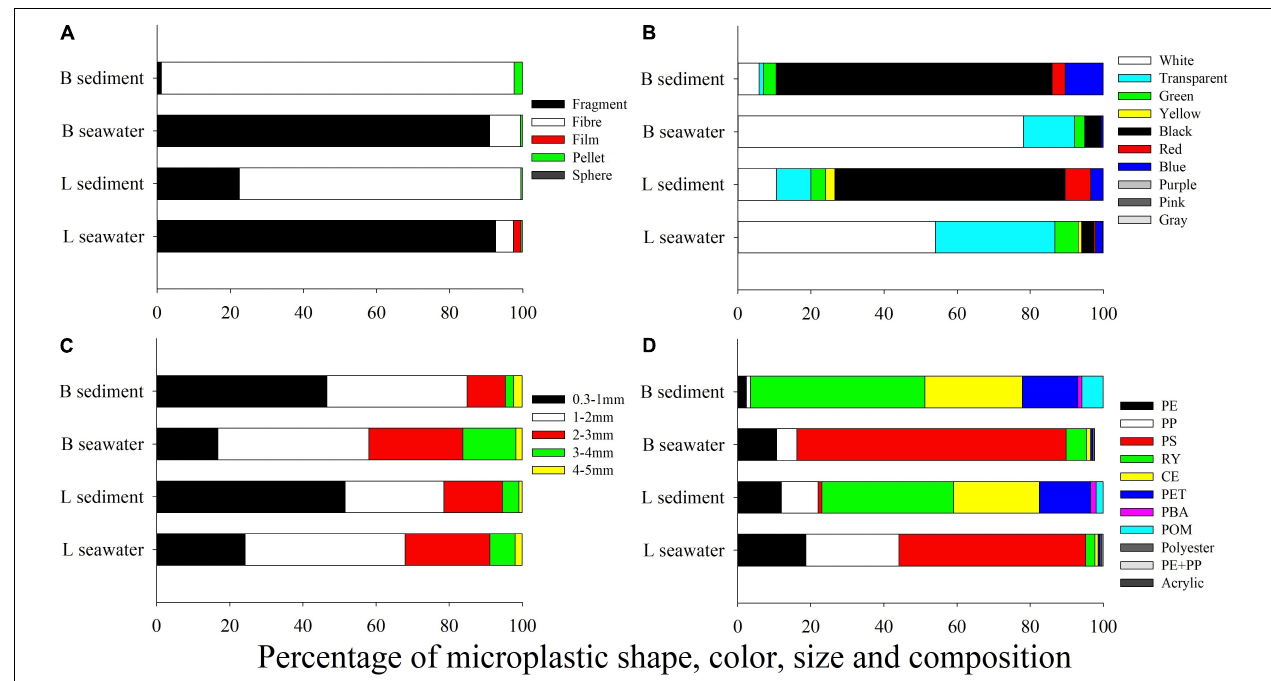
FIGURE 2 | Microplastic characteristics observed from the seawater and sediment samples in the Beibu Gulf (the northern South China Sea): shape (A) , color (B) , size (C) , and composition (D) .